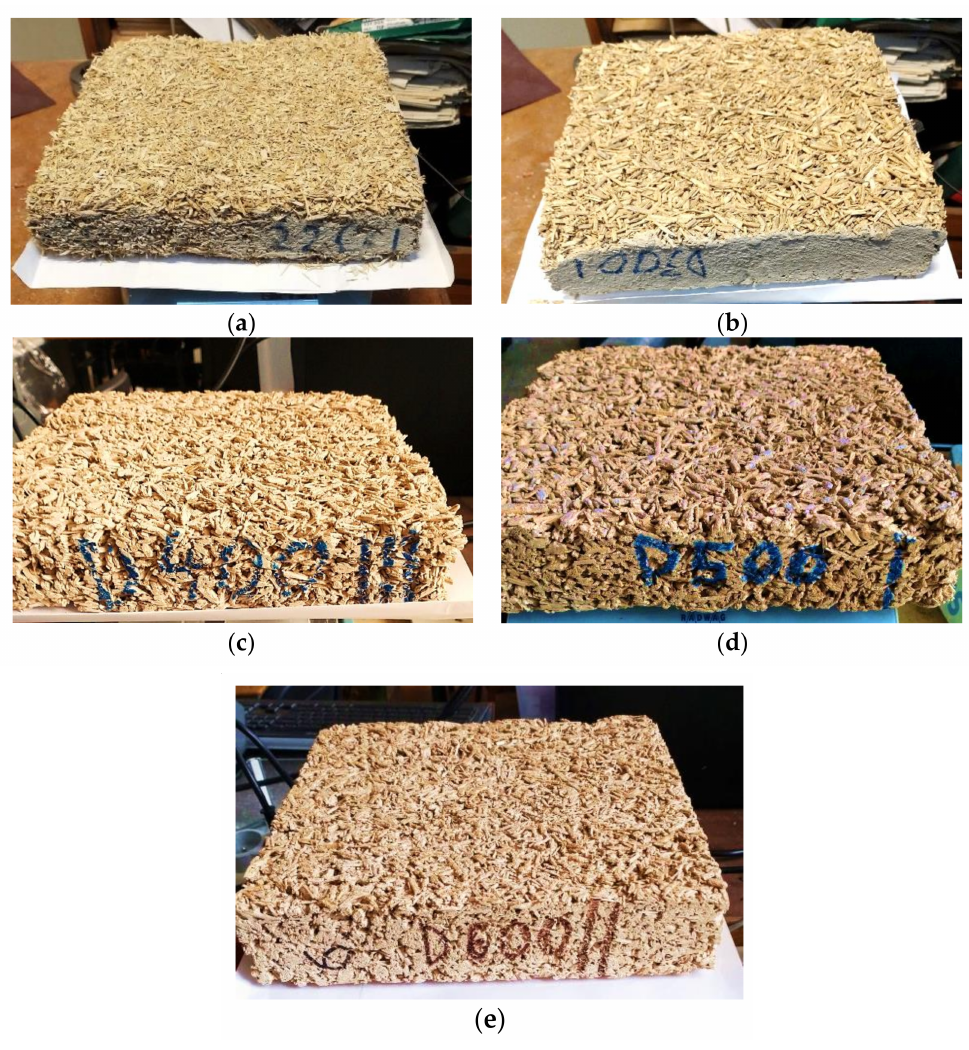
Figure 3. Pictures of exemplary samples: ( a ) D200, ( b ) D300, ( c ) D400, ( d ) D500, and ( e ) D600. The characteristic feature of hemp shive-reinforced composites is the open-pore struc- ture that can be seen in Figures 3 and 4.